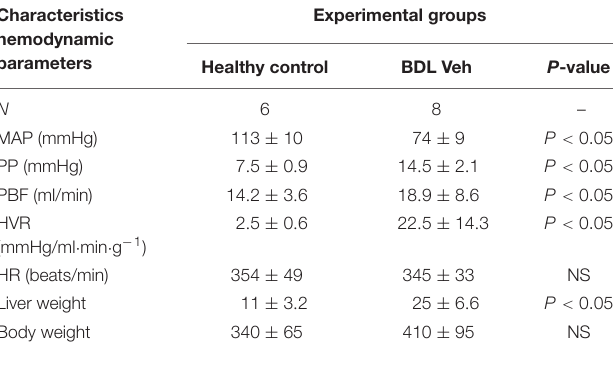
TABLE 2 | Hemodynamic parameters. Characteristics hemodynamic parameters